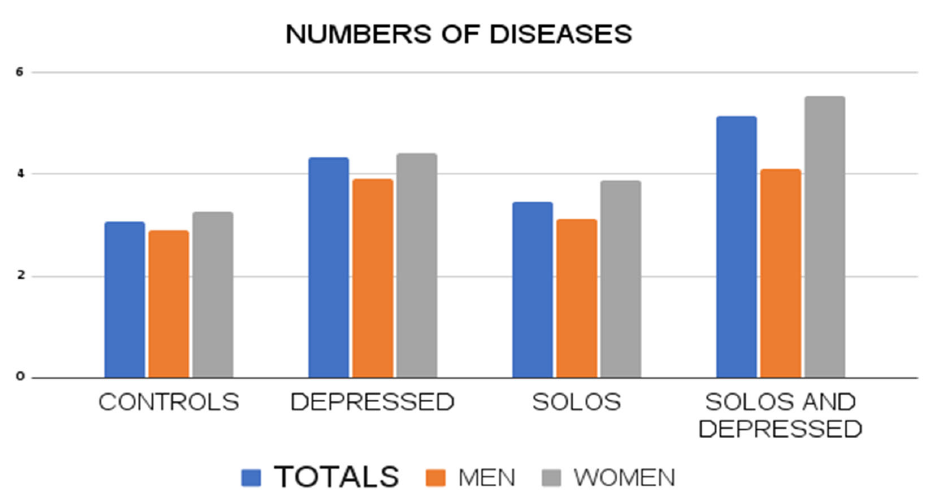
Figure 1. Graph of the number of total diseases in volunteers according to groupings (controls, depressed, solo, solo and depressed) and sex (total, men and women).